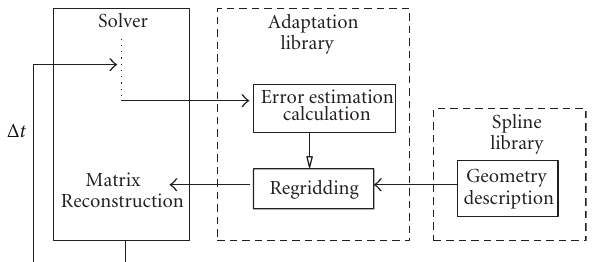
Figure 2: Brief schematic of the geometric library